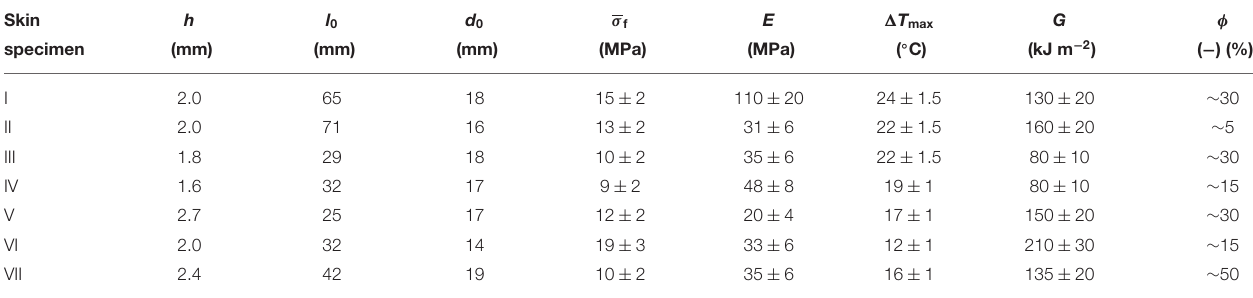
Figure 2 ) is also provided, with accuracy